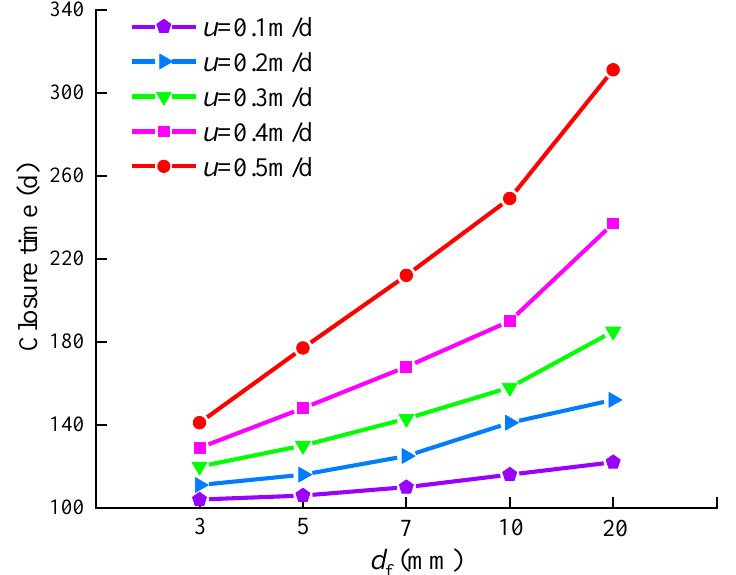
Figure 13. Closure time distributions of fractured rock mass with different fracture apertures under different groundwater seepage velocities, with u = groundwater seepage velocity and d f = fracture aperture.